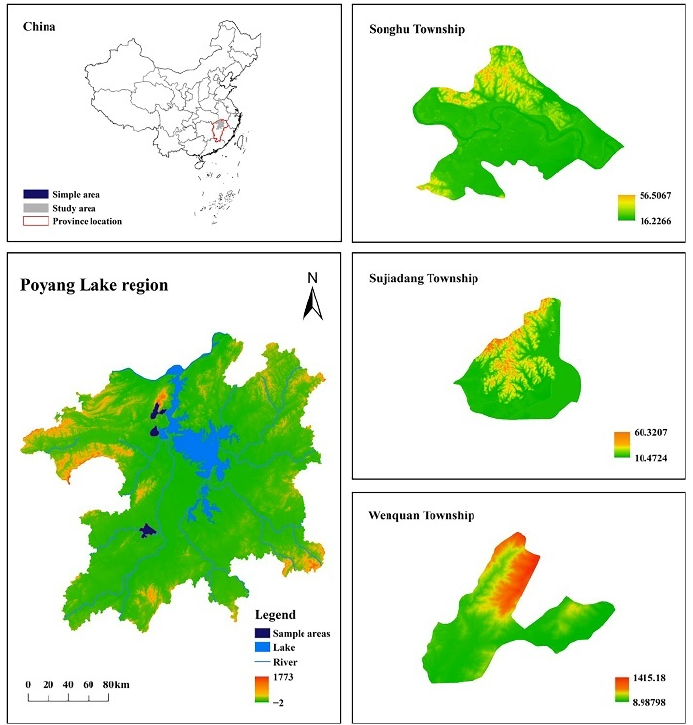
Figure 1. The location of the study domain.